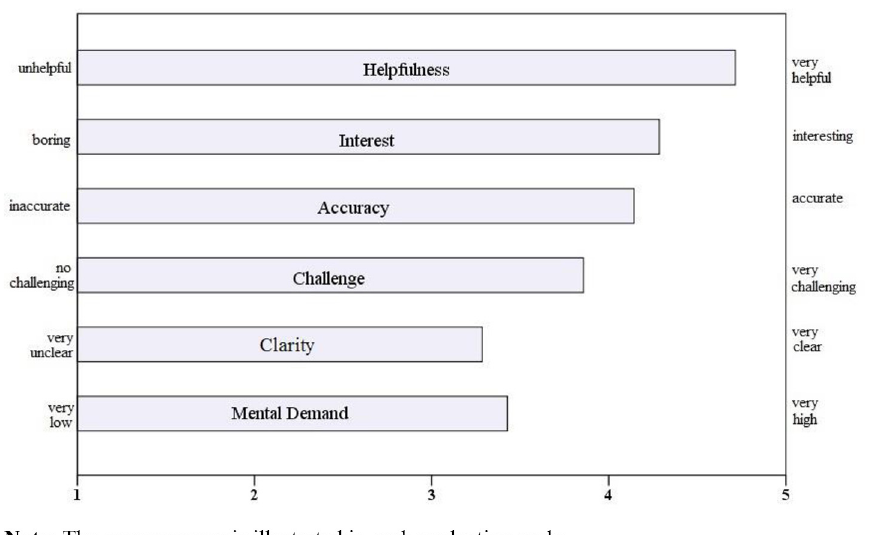
Figure 6. Participants